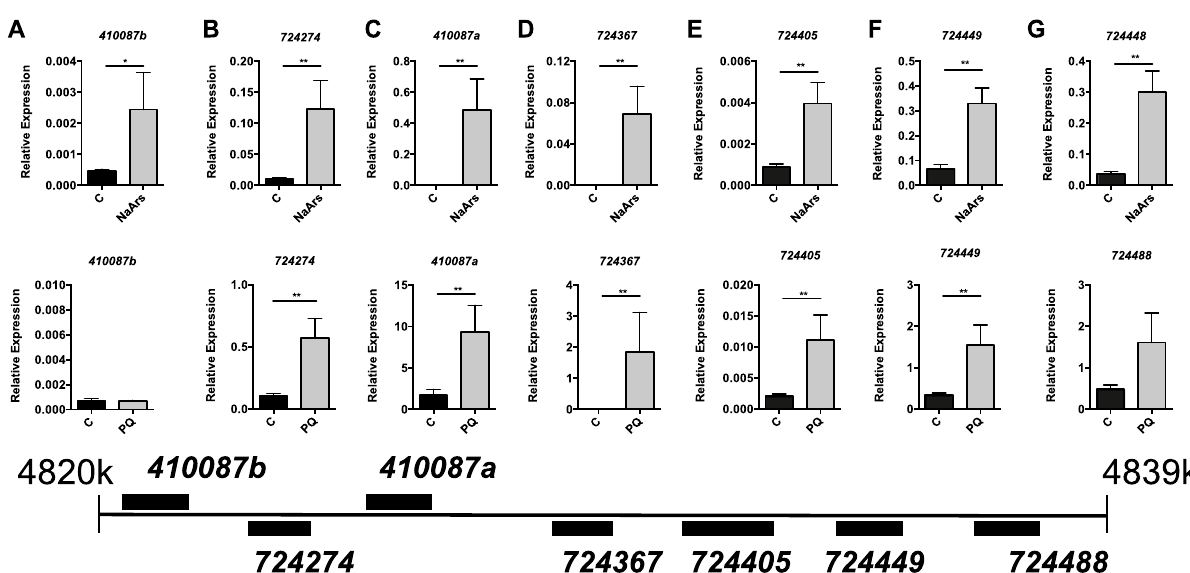
Figure 6. Select sHSP genes are induced during oxidative stress. Transcript levels of the l(2)efl genes 410087b ( A ), 724274 ( B ), 410087a ( C ), 724367 ( D ) , 724405 ( E ), 724449 ( F ), and 724488 ( G ) relative to β-actin in midgut tissue from adult bees captured at the landing board and fed sucrose solution alone (C, n = 8) or with 0.001% NaArs (n = 8) (top row) or fed sucrose solution alone (C, n = 8) or 1 mM paraquat (PQ, n = 8) (bottom row) for 24 h. A schematic diagram of the colocalized l(2)efl genes in the honey bee genome is shown below for reference. Mean ± SEM is shown and represents expression values of the genes of interest calculated using the 2 (−ΔCT) method for individual bees. Statistical significance is noted as *p < 0.05, and **p <